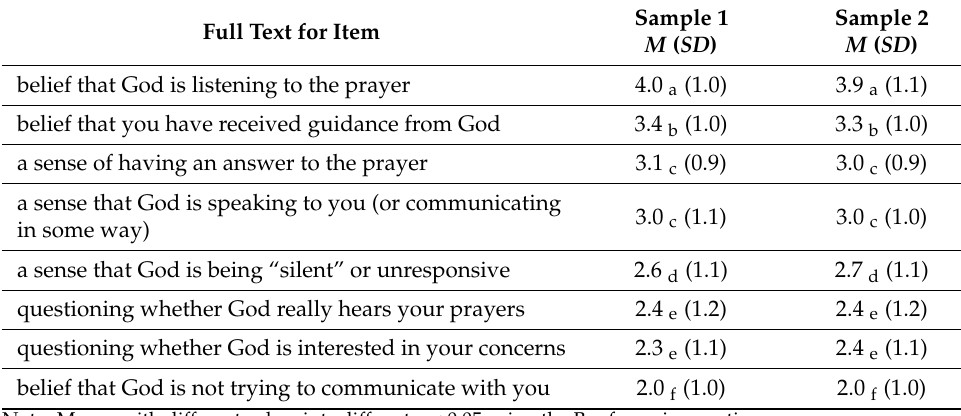
Table 2. Samples 1 and 2: Item-Level Means and Bonferroni-Corrected Comparisons on Divine Engagement and Disengagement